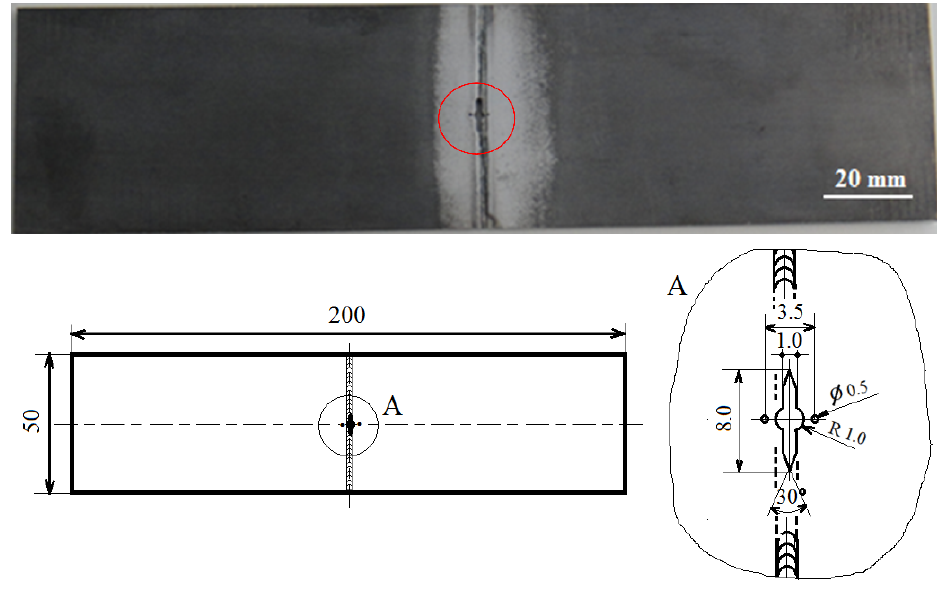
Figure 1. Specimen geometry used in FCGR tests, dimensions in mm.